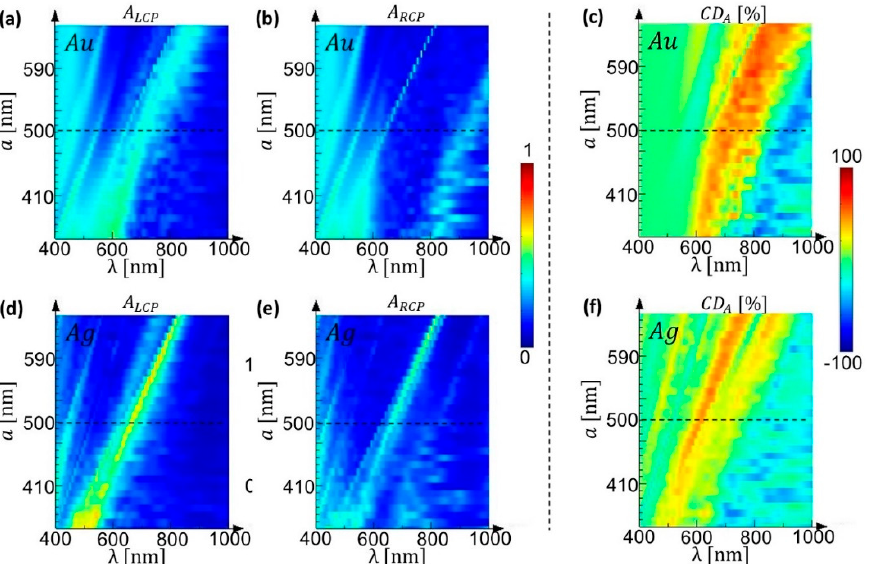
Figure 2. Passive simulations of chiral absorption in Au-ENHA and Ag-ENHA as dependences on lattice parameter a . ENHA diameters are scaled as D x = 280* a /500, D y = a , while the angle offset from the hexagonal symmetry is held at 15°. ( a ) A LCP , ( b ) A RCP , and ( c ) CD A for the Au-ENHA; ( d ) A LCP , ( e ) A RCP , and ( f ) CD A for the Ag-ENHA.